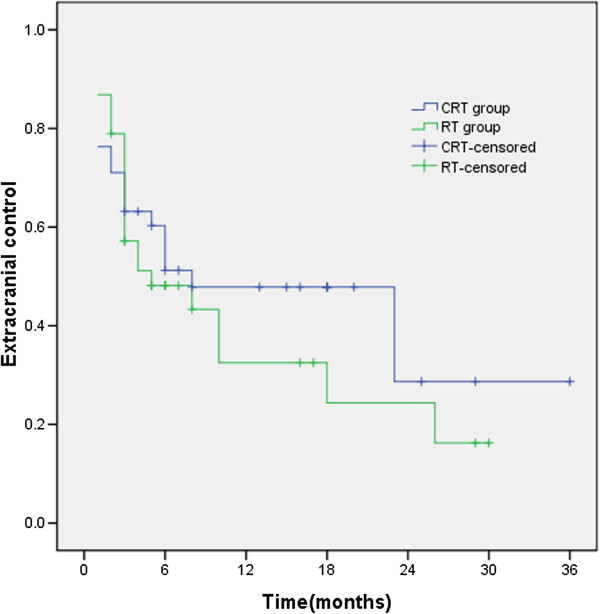
The 1- and 2-year extracranial lesion control rates of CRT and RT groups were 8 months, 47.8%, and 28.7% and 5 months, 32.5%, and 24.4% (χ2 = 0.610, p = 0.435), respectively.